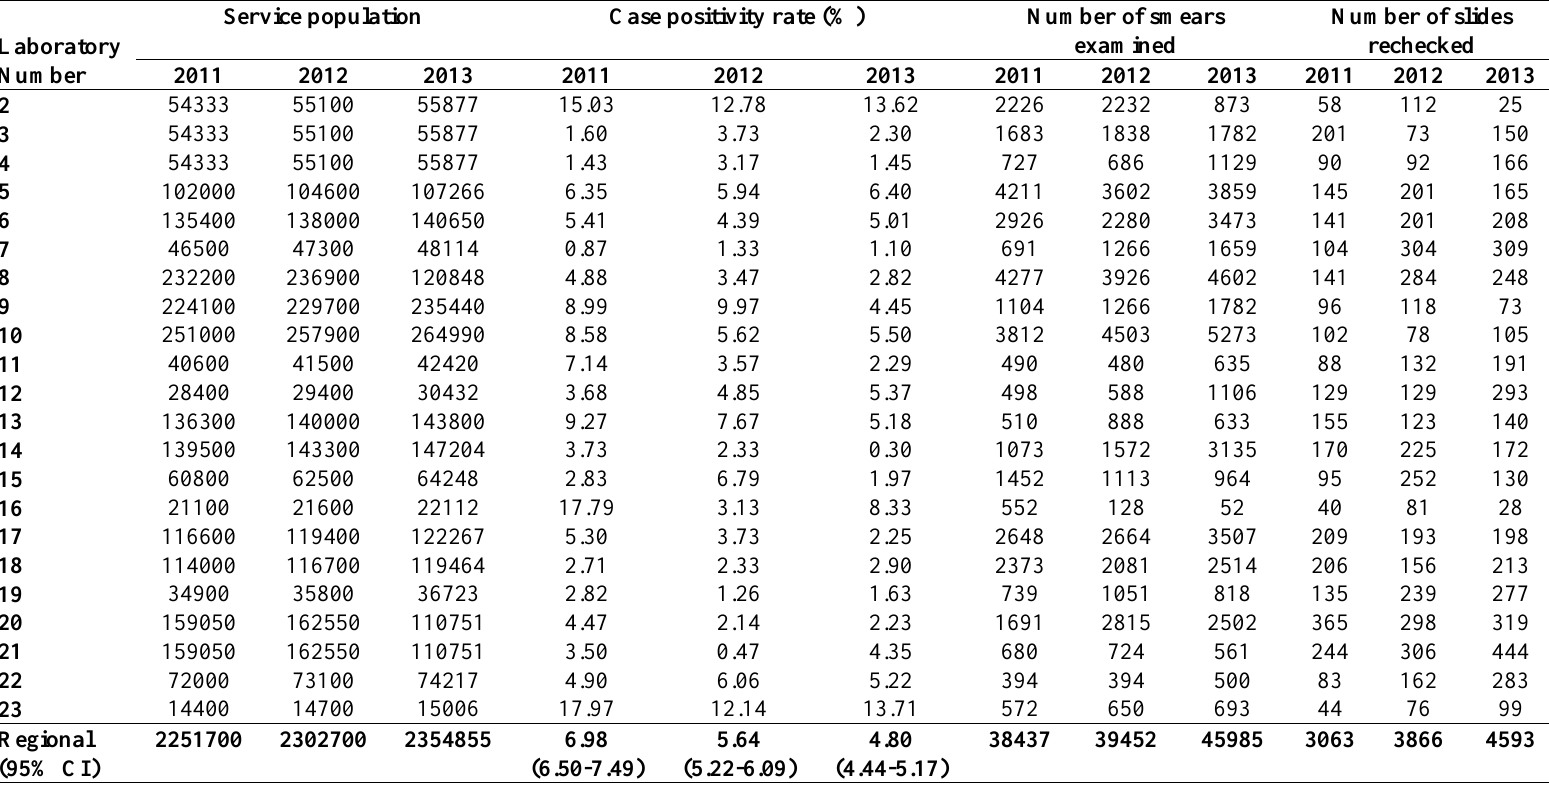
Table 2: Overview of the annual service population, case positivity rate, total number of smears, and total number of slide rechecking from 2011 to 2013 among TB microscopic laboratories in Sughd, by laboratory